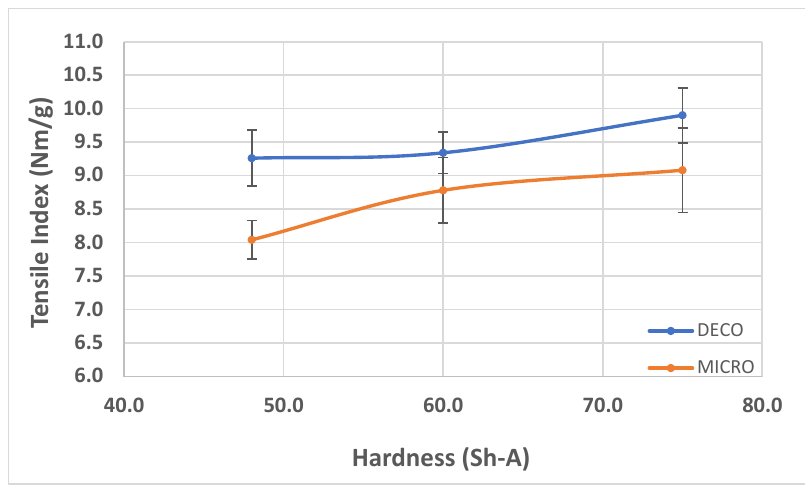
Figure 8. Tensile index behavior with the increase in rubber hardness.